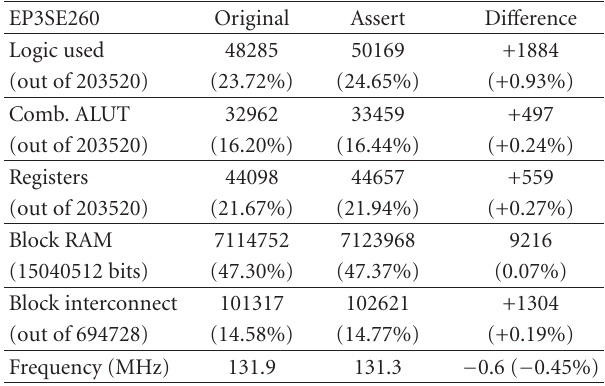
Table 6: Looped backprojection timing assertion overhead.